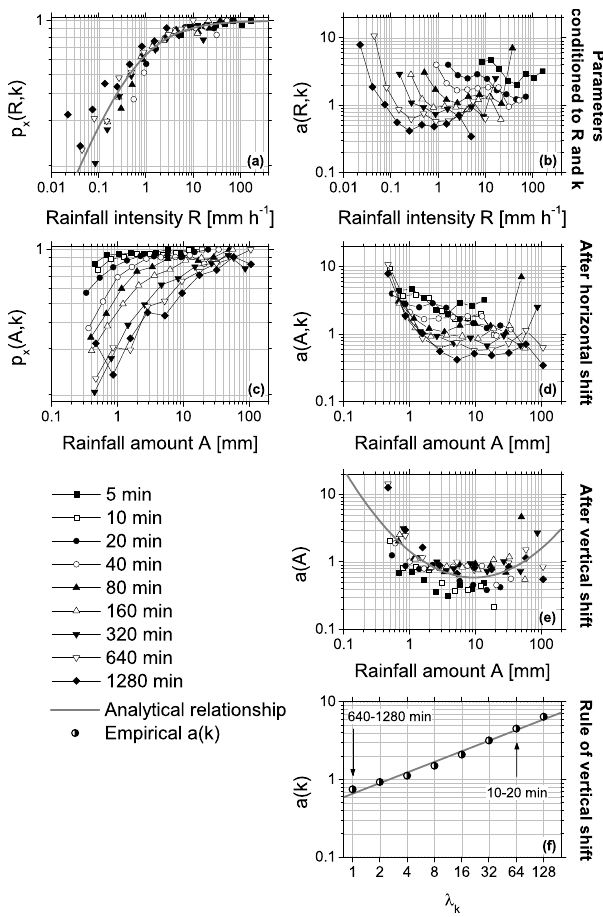
Fig. 3. Relationships among MC parameters, time scale, and rain- fall intensity R or amount A